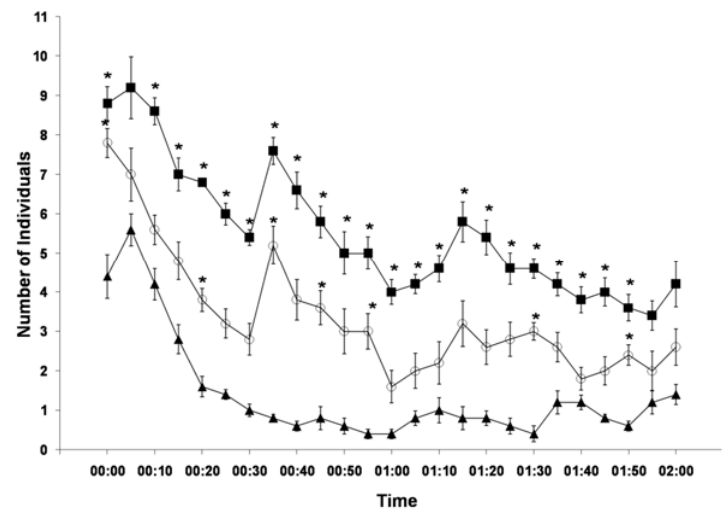
Figure 3. Mean number of animals observed in the test area ± standard error of the mean ( n = 35) during the two hours of video recording in four days for the three categories of results.With enrichment (